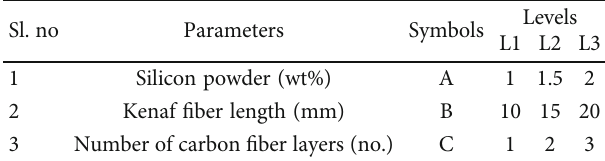
Table 3: Taguchi L